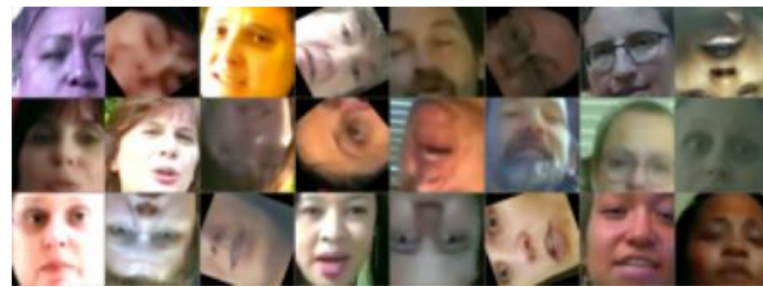
Figure 4. Samples of faces after